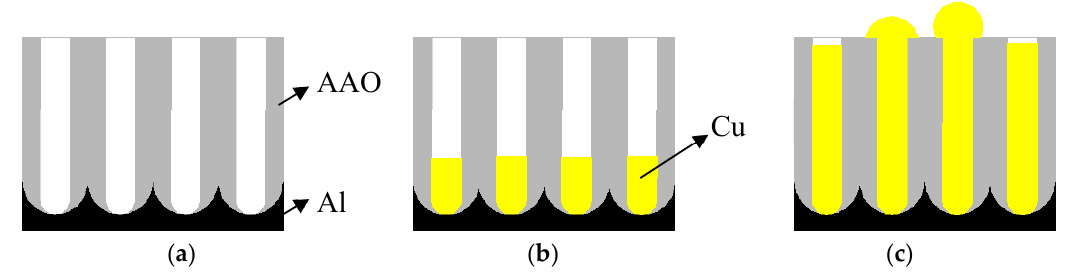
Figure 6. Growth model of composite alumina film ( a ) 0 min, ( b ) 10 min, and ( c ) 30 min